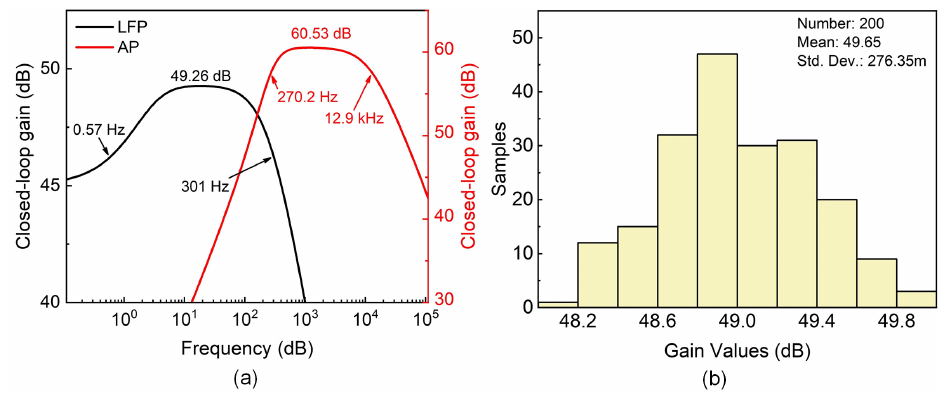
Figure 4. ( a ) Measured closed-loop gain of the amplifier for detecting both the action potential (AP) and the local field potential (LFP) in different bandwidths, ( b ) Monte Carlo simulation of the AC gain of LFPs for 200